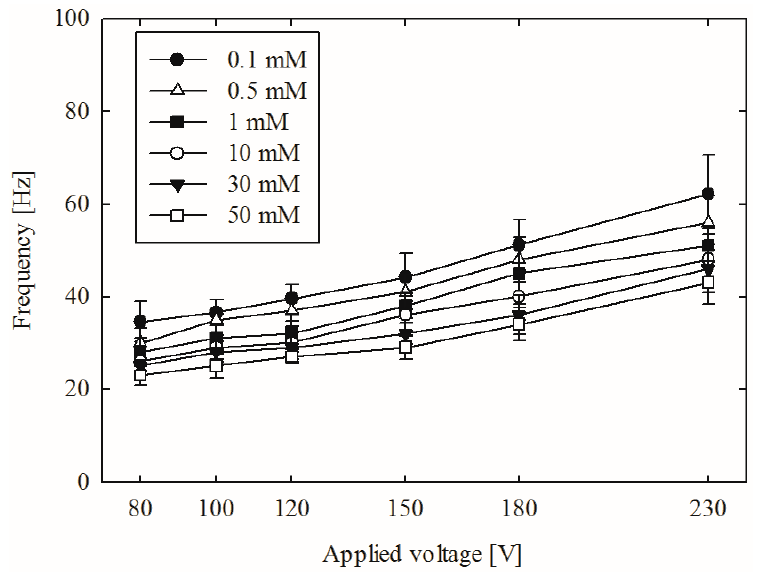
Figure 5. Spectral analysis results with different solution concentrations.